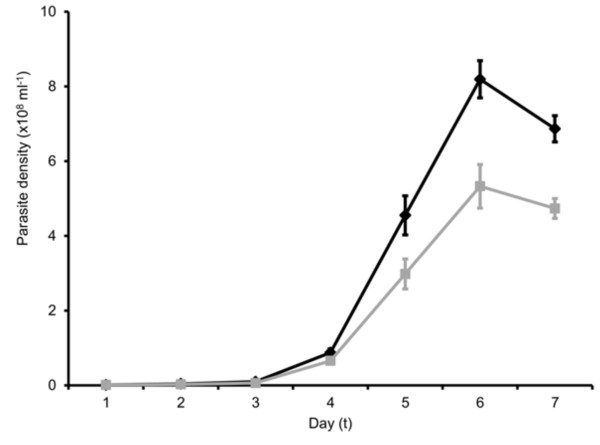
Matched parasites performed better than mismatched parasites throughout the pre-peak phase of the infection. Temporal dynamics of all infections (route and stage treatments combined) followed from day 1 to day 7 pi. The mean (±se) densities of matched (black lines) and mistmatched (grey lines) infections are plotted.